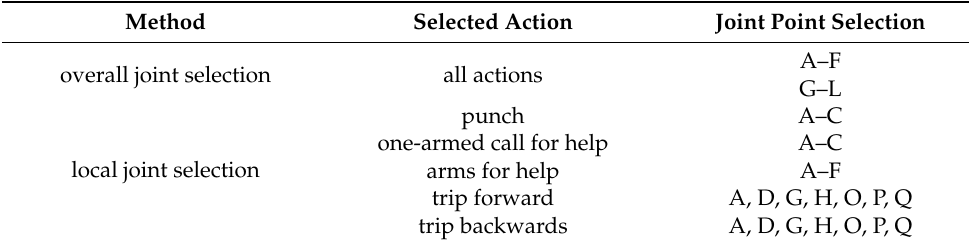
Table 3. Joint point